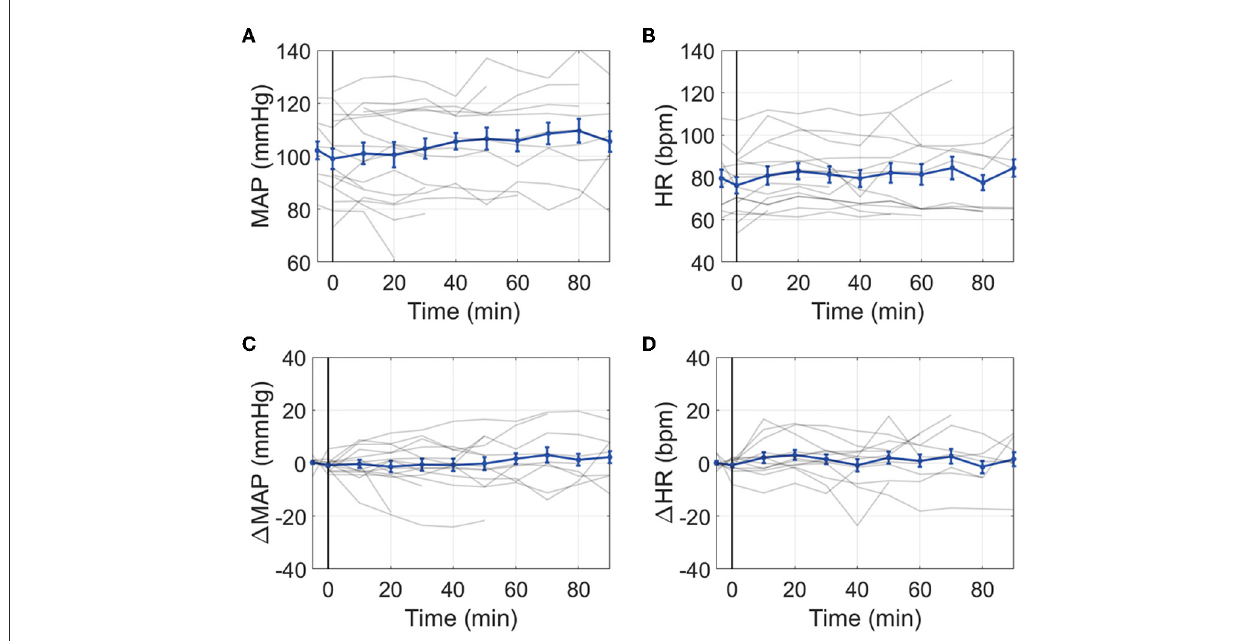
FIGURE2 Effect of IT nicardipine on systemic blood pressure and heart rate: Mean arterial pressure [MAP, (A) ], heart rate [HR, (B) ], change in MAP from pre-administration levels [ 1 MAP, (C) ], and change in HR from pre-administration levels [ 1 HR, (D) ] as a function of time post-administration of IT nicardipine. Thin gray lines in each subplot denote individual patient responses, and thick blue lines denote the mean and standard deviation across all patients. The black vertical line at time = 0 denotes the start of treatment.